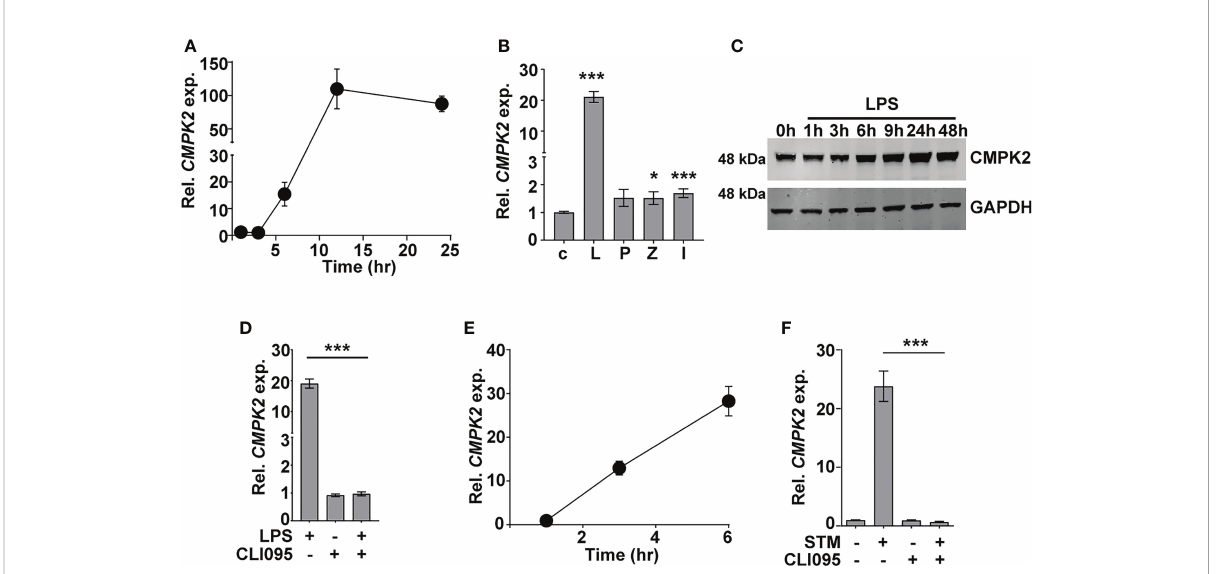
FIGURE 1 CMPK2 expression is induced following TLR4 stimulation of infection. (A – F) Analysis of CMPK2 expression in THP1 macrophages following: infection with Mtb at a MOI of 5 (A) , stimulation with various TLR ligands — c, untreated cells; L, LPS (10 ng/ml); P, Pam3CSK4 (20 ng/ml); Z, Zymosan (10 µg/ml); I, poly IC (2 µg/ml), (B) LPS stimulation by immunoblotting with CMPK2-speci fi c antibody, (C) LPS stimulation with and without TLR4 inhibitor CLI095, (D) Infection with STM, (E) Infection with STM in the presence of CLI095, (F) Expression of CMPK2 was quantitated by qPCR. Values are normalized with GAPDH and mean fold change compared to control cells ± SEM from N = 3 independent experiments. Mtb, Mycobacterium tuberculosis ; MOI, multiplicity of infection; LPS, lipopolysaccharide; STM, Salmonella enterica subsp. enterica serovar Typhimurium. *p<0.05,